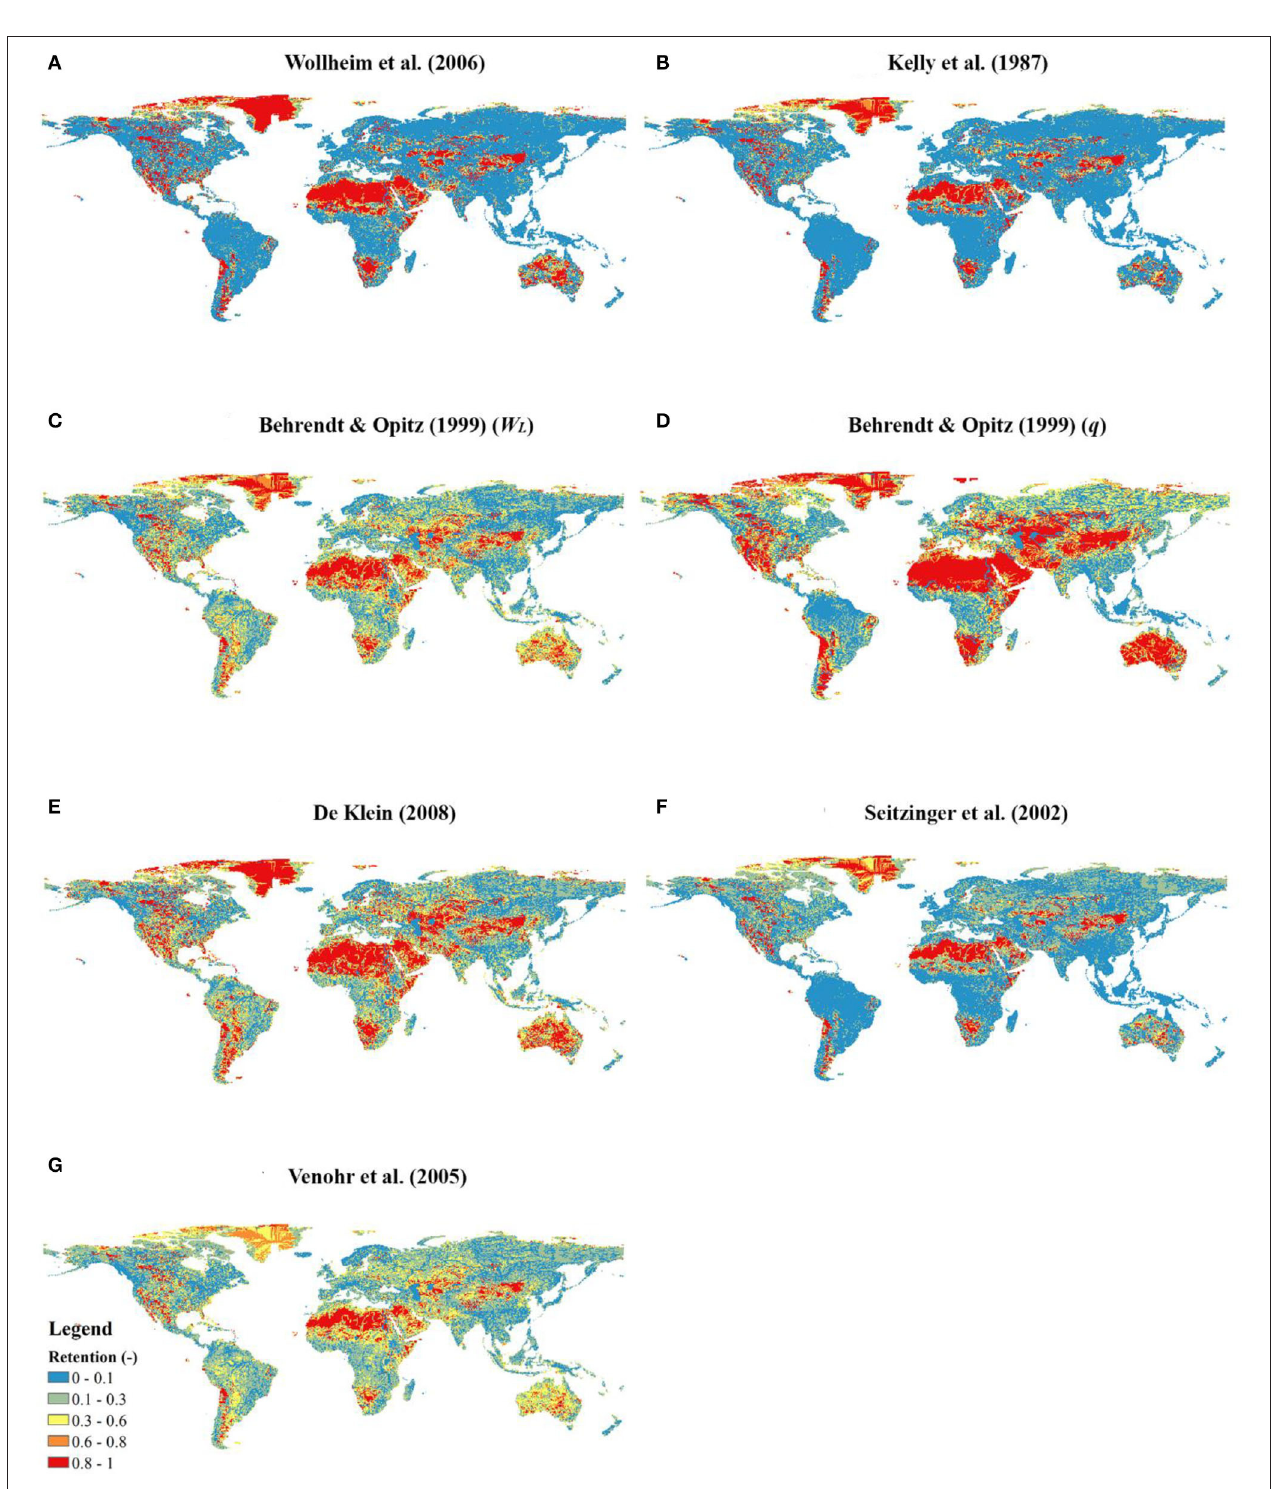
FIGURE 5 | N retention for different models at a half-degree resolution (Retention is dimensionless, and the unit was labeled as “-”). (A–G) indicate the plots of different retention models.